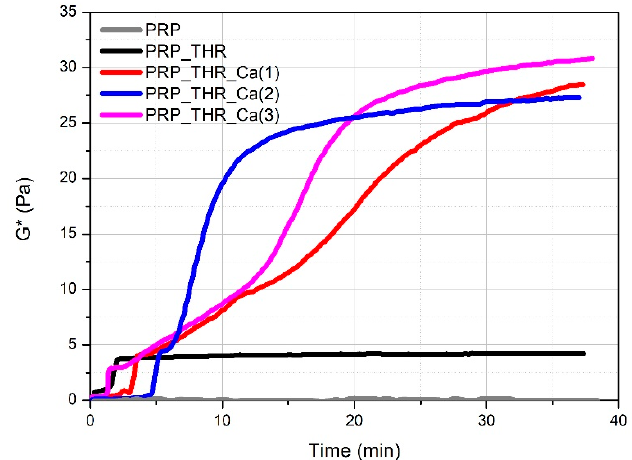
Figure 2. Variation of the complex modulus (G*) over time for PRP alone (PRP), PRP after activation with thrombin (PRP_THR) and in the presence of Ca 2+ at the three tested concentrations [PRP_THR_Ca(1), 7.7 mM; PRP_THR_Ca(2), 15.4 mM; PRP_THR_Ca(3), 23.1 mM] from time sweep tests at 25 °C.